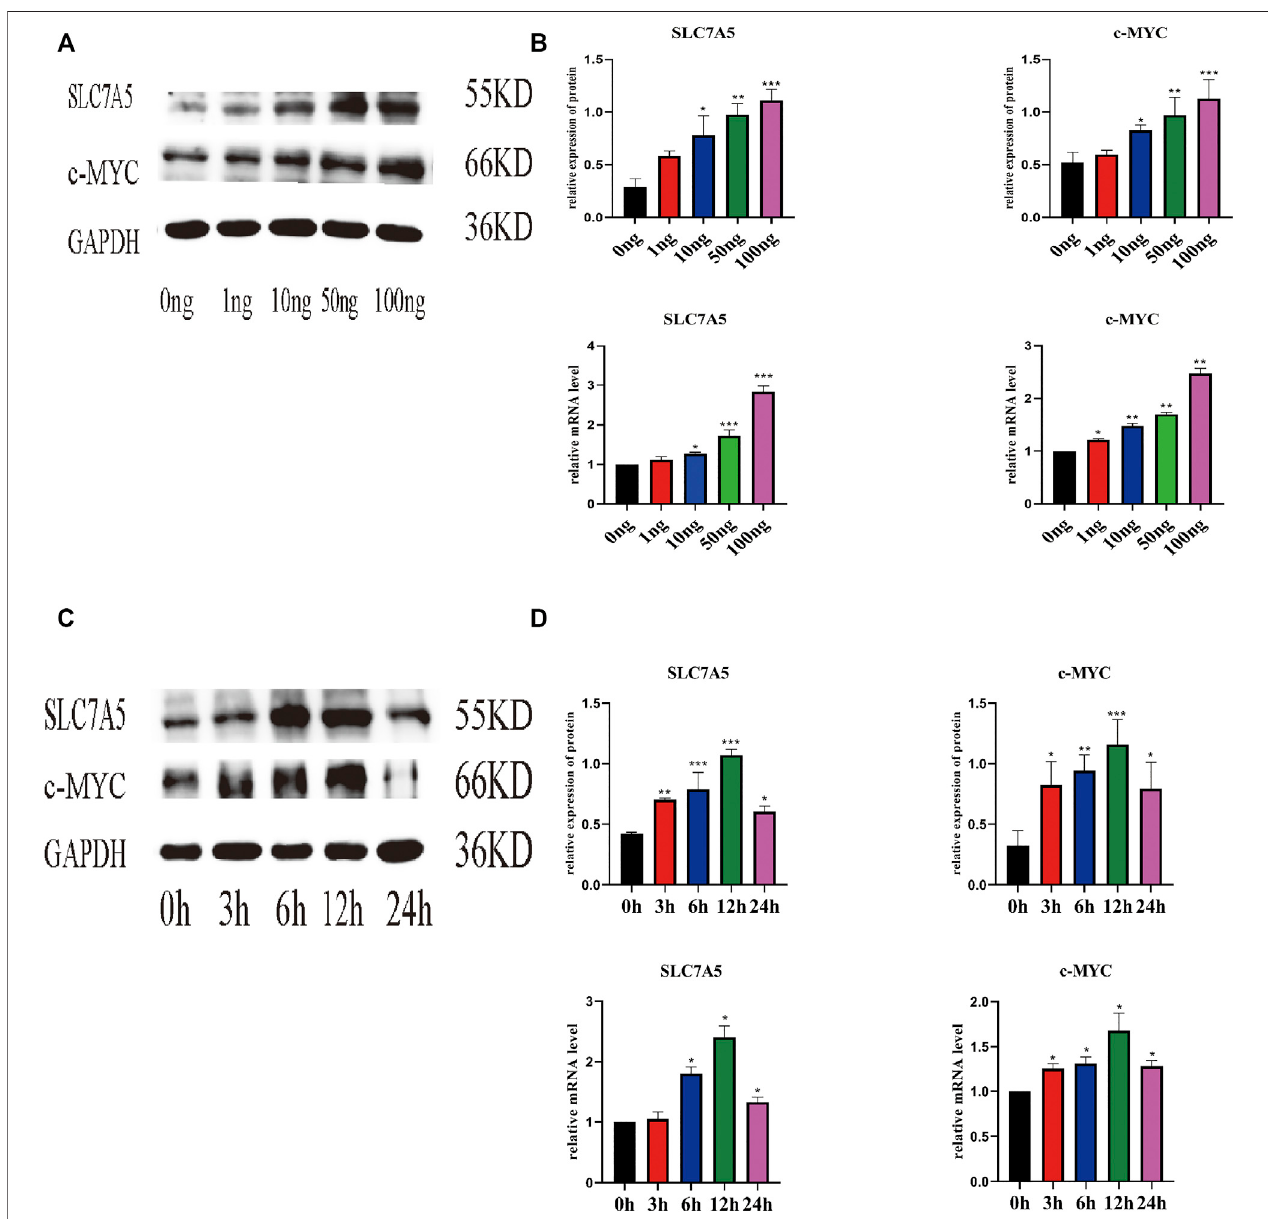
FIGURE 3 | IL-18 induced the expression of SLC7A5 and – MYC in a dose- and time-dependent manner. hBMSCs were treated with different culture concentrations (0, 1, 10, 50, 100 ng) of IL-18, western blot and qPCR were used to evaluate the protein and mRNA (A, B) expression levels of SLC7A5, c-MYC, and GAPDH. hBMSCs were treated with 100 ng/ml IL-18 for 0, 3, 6, 12, and 24 h, and Western Blotting and qPCR were used to evaluate the protein expression of SLC7A5,c-MYC and GAPDH (as internal control) and their mRNA expression (C, D) . Data are expressed as the mean ± standard deviation (SD). Concentration groups vs. the control (0 ng) group; time-point groups vs. the control (0 h) group, Experiments were repeated three times. * p < 0.05, ** p < 0.01, *** p < 0.001.